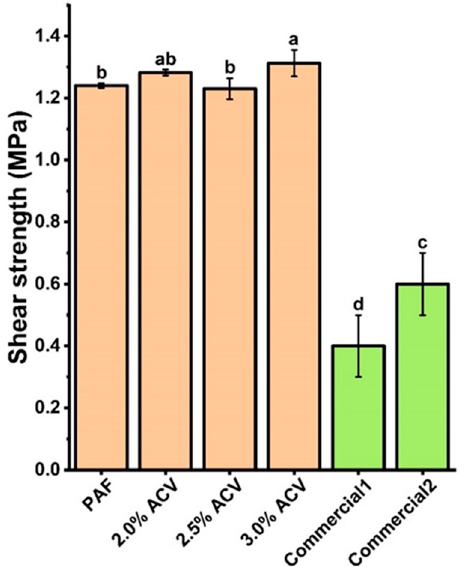
Figure 4. The shear strengths of the PAF and ACV/PAF adhesives on the paper substrates compared with two commercially available water glues. Letter notation on top of the bar-graphs indicated group classi fi ed by statistical analysis. Similar notation means that data are statistically the same ( p ≤ 0.05).